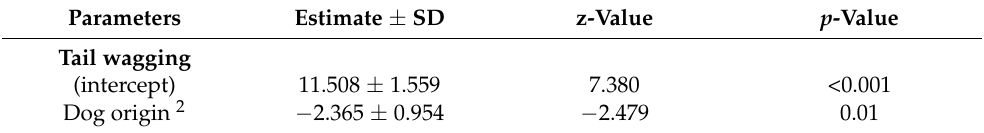
Table 5. Final reduced model (GLMM2) of effects of dog origin and sex on the time spent wagging the tail, time spent within 1 m of the trainer, non-training behaviors, and time spent oriented to trainer, as recorded during all training sessions with shelter and companion dogs 1 .